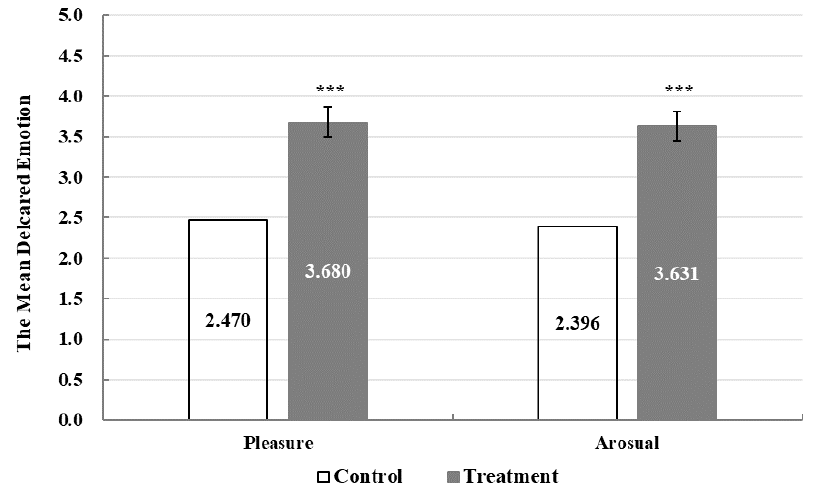
Figure 2. The impact of overall intervention on tourists’ momentary emotional experience. Note: Error bars represent 95% confidence interval. *** p < 0.001.